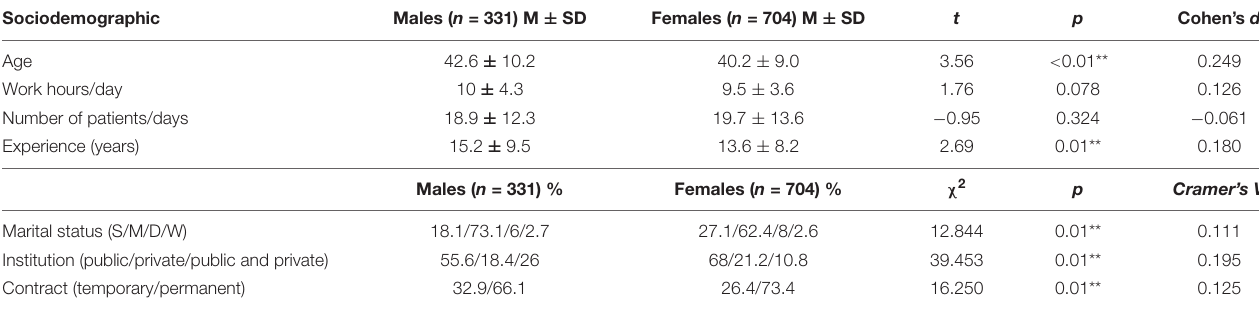
TABLE 1 | Gender differences among the sociodemographic variables.